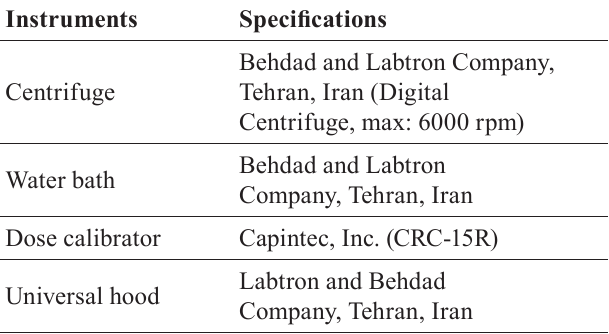
TABLE I - T he specifications of materials and instruments used in this study